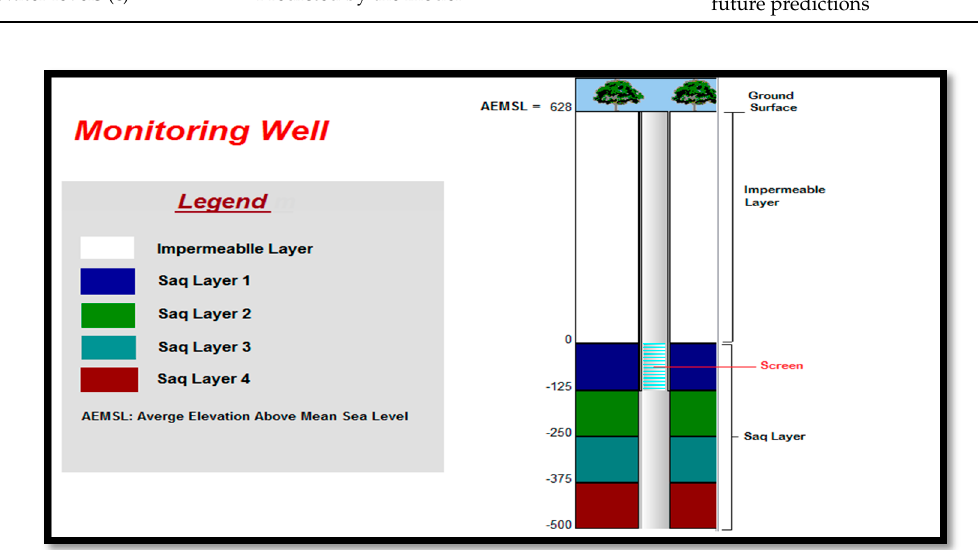
Figure 5. Layers of the Saq Aquifer for MODFLOW Models.